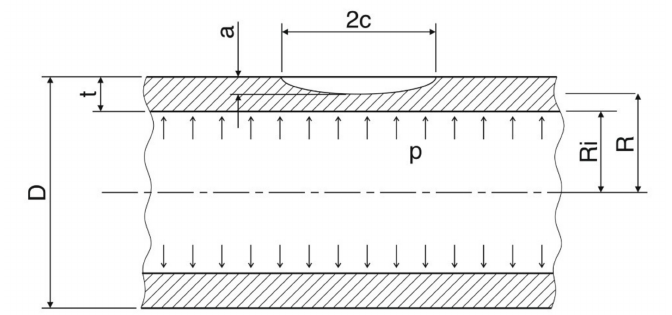
Figure 19. A longitudinal semi-elliptical part-through crack in a thin-walled